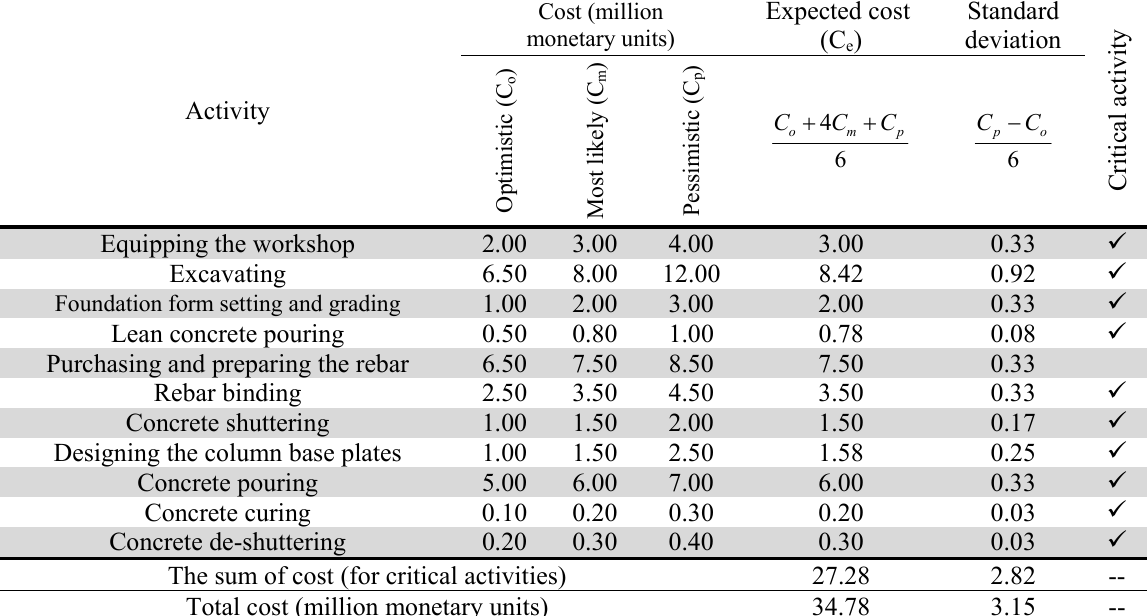
Calculation of expected cost and standard deviation using PERT